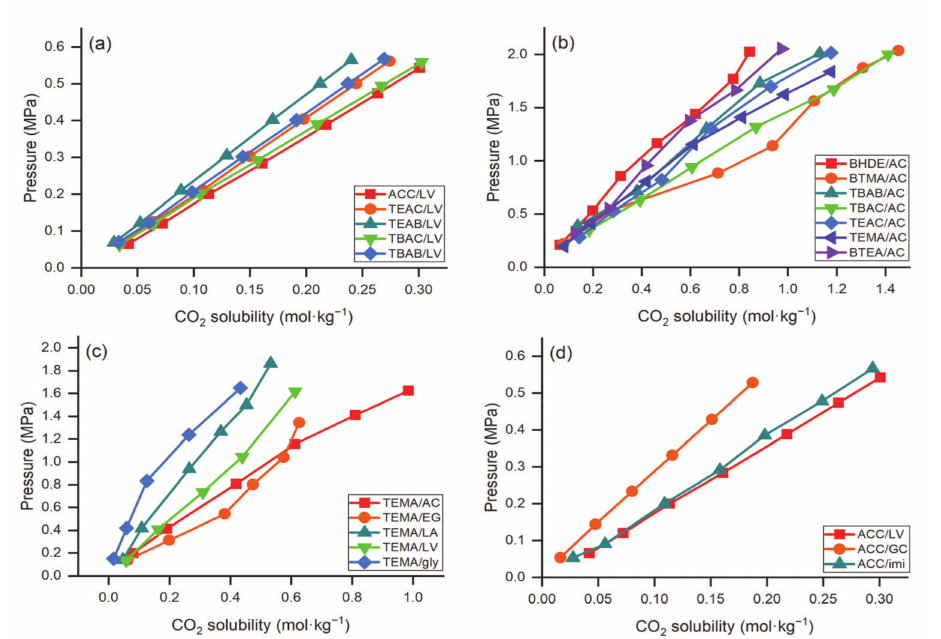
Figure 3. Effect of ( a ) HBA of LV-based DESs on CO 2 solubility at 303.15 K, ( b ) HBA of AC-based DESs on CO 2 solubility at 298.15 K, ( c ) HBD of TEMA-based DESs on CO 2 solubility at 298.15 K, and ( d ) HBD of ACC-based DESs on CO 2 solubility at 303.15 K, data are extracted from [56,57,61].